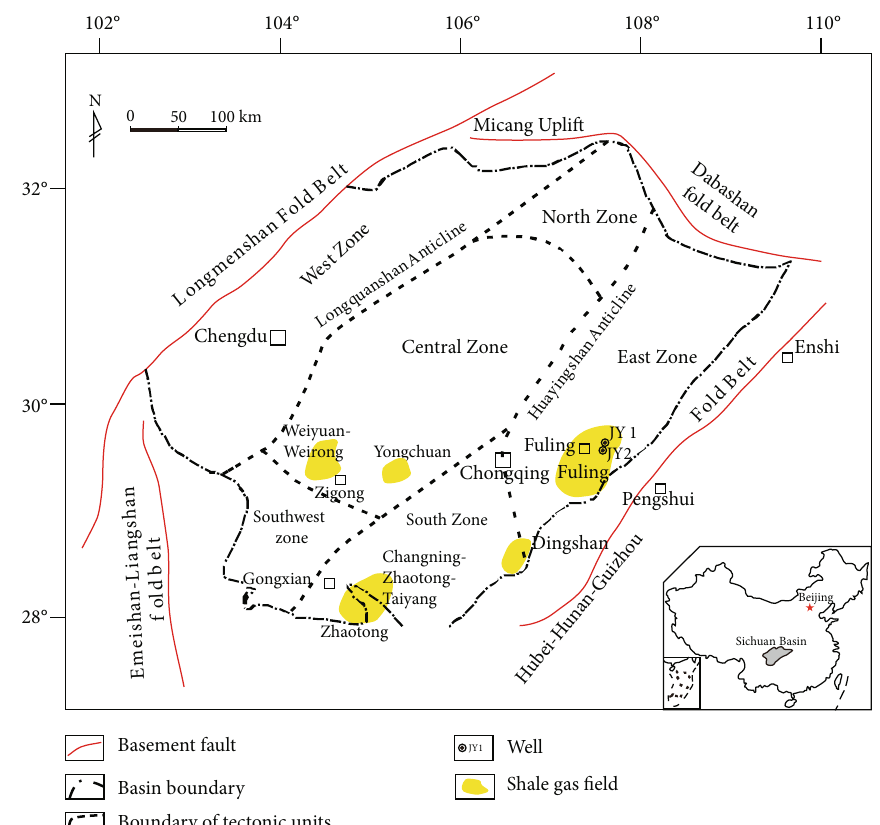
Figure 1: Location map of the study area in the Sichuan Basin, China; the structural subdivisions include the eastern, southern, western, northern, southeastern, and central zones (after